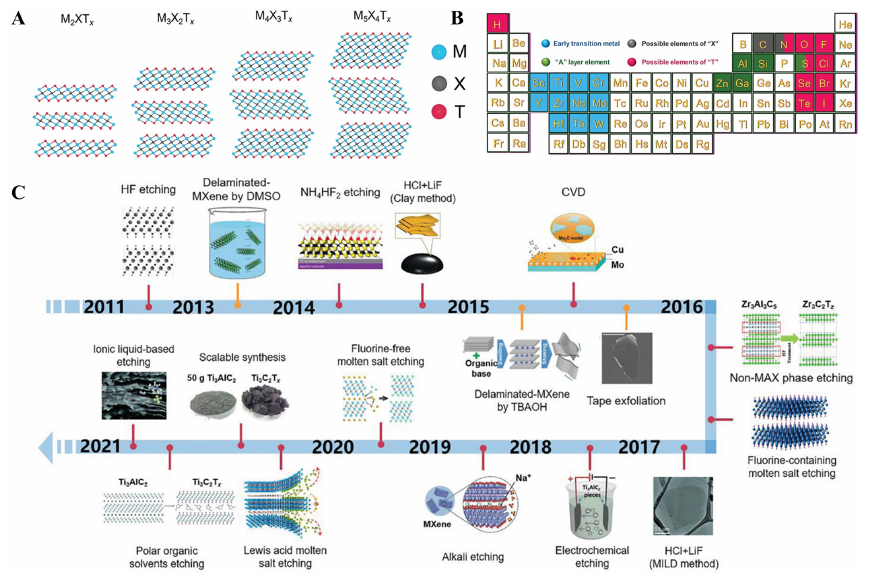
Figure 17. ( A ) Structure of various MXenes with surface terminations. ( B ) Periodic table elements experimentally used for the synthesis of MXenes, and ( C ) Timeline of the various synthesis routes to MXenes. Reproduced with permission from Ref. [117] . Copyright 2021, Wiley. Table 3. Recent literature reports on metal nanoparticles incorporated MXenes for electrochemical biomarker detection.